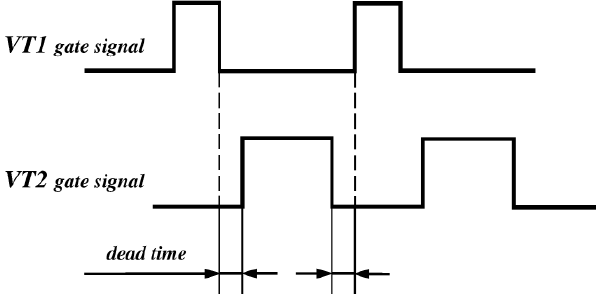
Fig. 10. Gate signal waveforms in VT1 and VT2 in buck converter with the synchronous